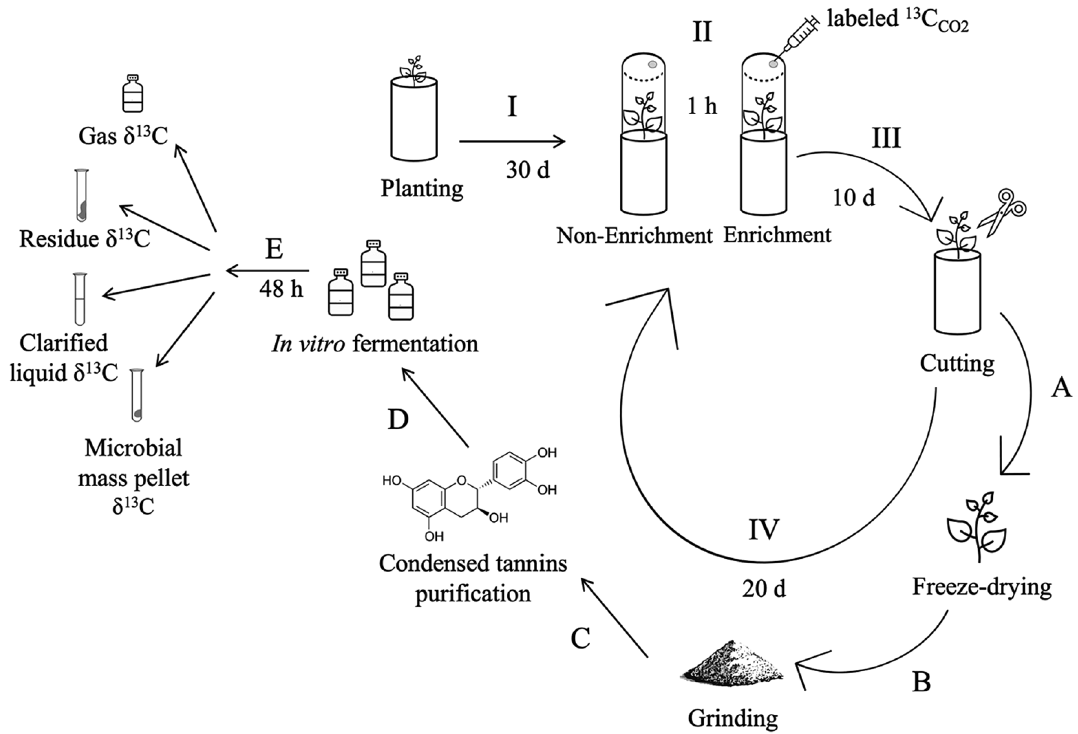
Figure 3. Depiction of Trial 2. Step I was carried out one time at the greenhouse. Steps II–IV were performed four times (experimental periods) at the greenhouse. Steps A–E were performed four times (experimental periods) at the